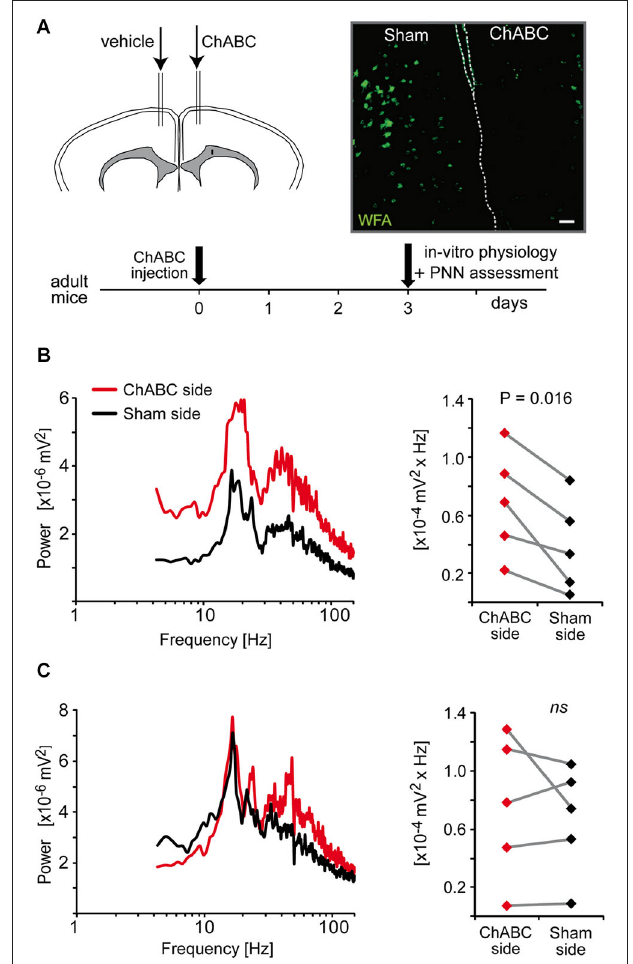
FIGURE 5 | Enzymatic removal of the perineuronal nets (PNNs) by local injection of chondroitinase ABC (ChABC) increases the power of high-frequency oscillations induced by a mixture of quinpirole, kainate and carbachol (Quinp/KA/Carb). (A) Schema of the experimental protocol of ChABC and control vehicle injections followed by electrophysiological and histological assessment. Micrograph illustrates the integrity of PNNs (as assessed with WFA labeling) in the vehicle-injected side (sham ACC, left ) and in the ChABC-injected side ( right ). Dashed lines indicate separation between hemispheres. Scale: 80 µ m. (B) In coronal slices that show a degradation of PNNs in the ChABC-injected ACC (as assessed by the WFA labeling), the power of the oscillations is significantly larger in the ChABC-injected ACC compared to the contralateral control ACC (sham-injected). (C) In coronal slices that are anterior or posterior to the ChABC injection site (the PNNs remain intact as assessed by WFA labeling), the power of the oscillations in the ACC of the two hemispheres is not significantly different from each other. Left graphs: power spectra of recordings from the ChABC-injected ACC (red) and from the contralateral sham ACC (black) (mean of pooled data). Note for the right graphs: the power values in the β band recorded in the ChABC-injected side and the control sham side from the same brain slice are connected by a